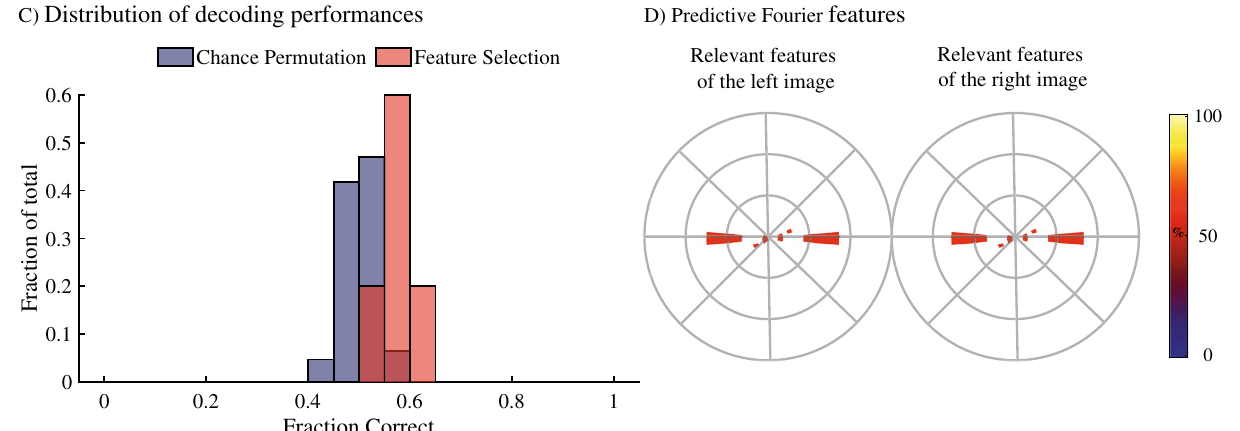
Figure 2. Results for decoding which image is detected first for faces with different expressions (top row) and for faces that have the same type of expression (bottom row). ( A,C ) The pool of decoding performances for the feature selection and the control models. On their y-axes is the fraction of models that show a particular performance. Chance performances from the control models are shown in purple, performances of the feature selection models are shown in red. ( B,D ) The locations of the features that were found to be significant for decoding within Fourier space for the images to the right and to the left of fixation separately. Note that in these Fourier space images, the angle between a point and the centre indicates the propagation direction of the waveform. As such, points on the horizontal axis indicate light–dark changes from left to right and therefore correspond to contrasts in vertical orientations within the images. The coloured areas in the Fourier spaces show the locations of the significant features with their colour reflecting their associated performances in percentage correct as shown in the colours on the